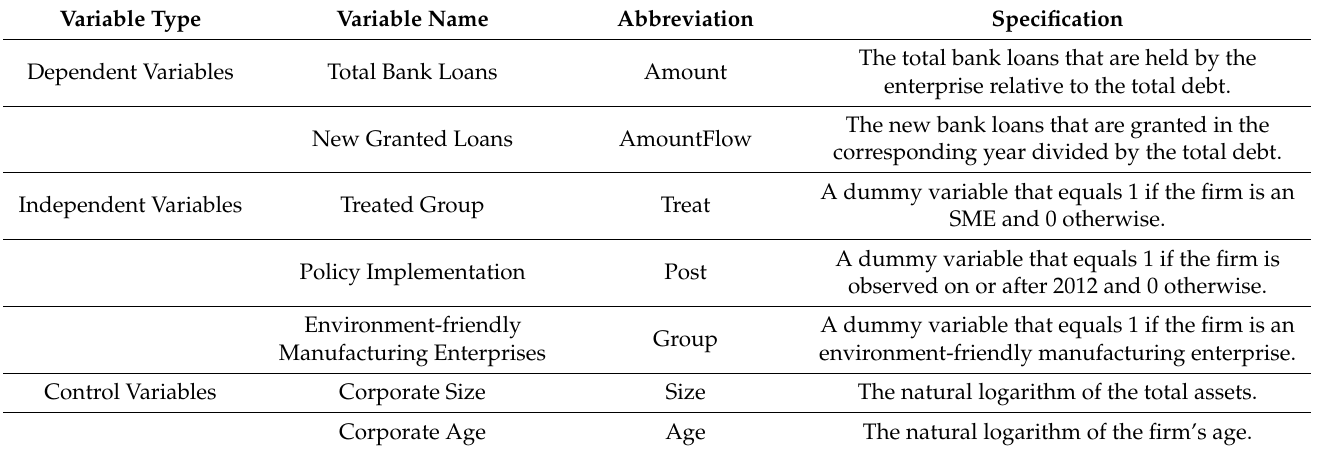
Table 1. Specifications of